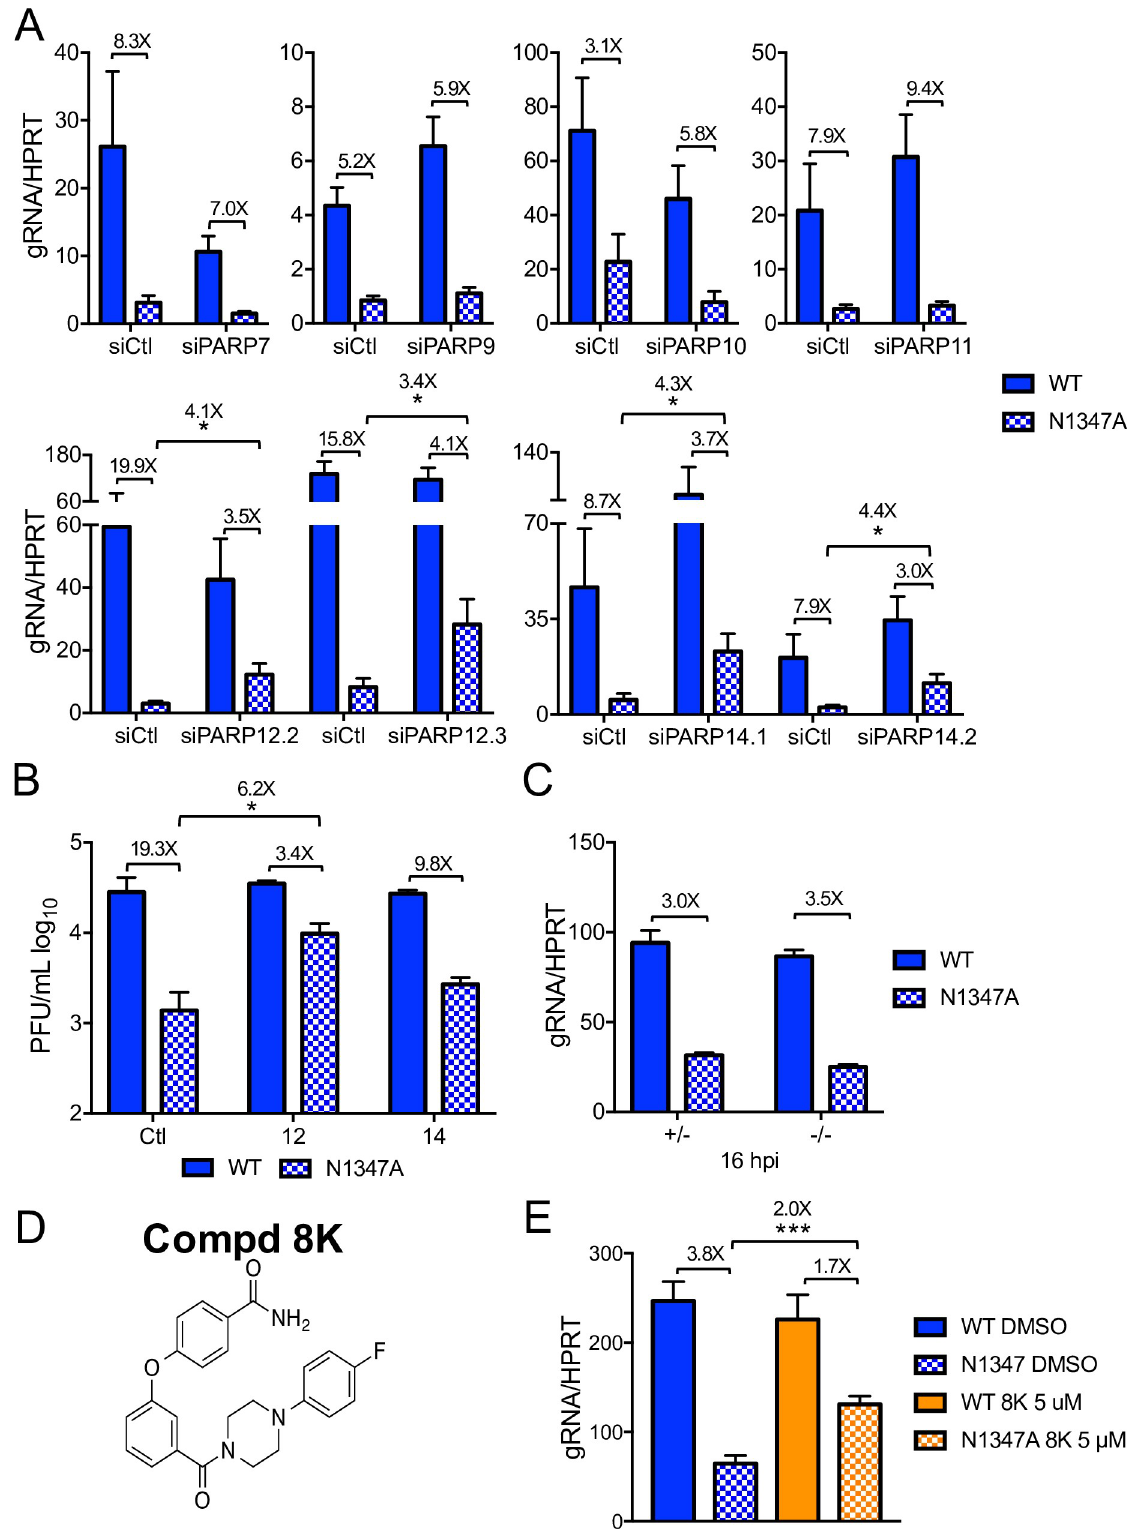
Fig 5. PARP12 and PARP14 restrict N1347A MHV replication in BMDMs. (A,B) BMDMs were transfected with control siRNA (siCtl) or PARP-specific siRNA as described in Methods. Approximately 28 hours later, cells were infected with WT or N1347A MHV and collected